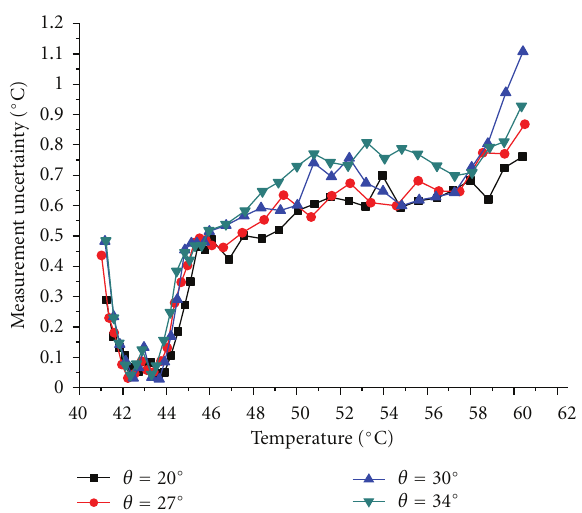
Figure 7: E ff ect of the TLC coating thickness on the measurement